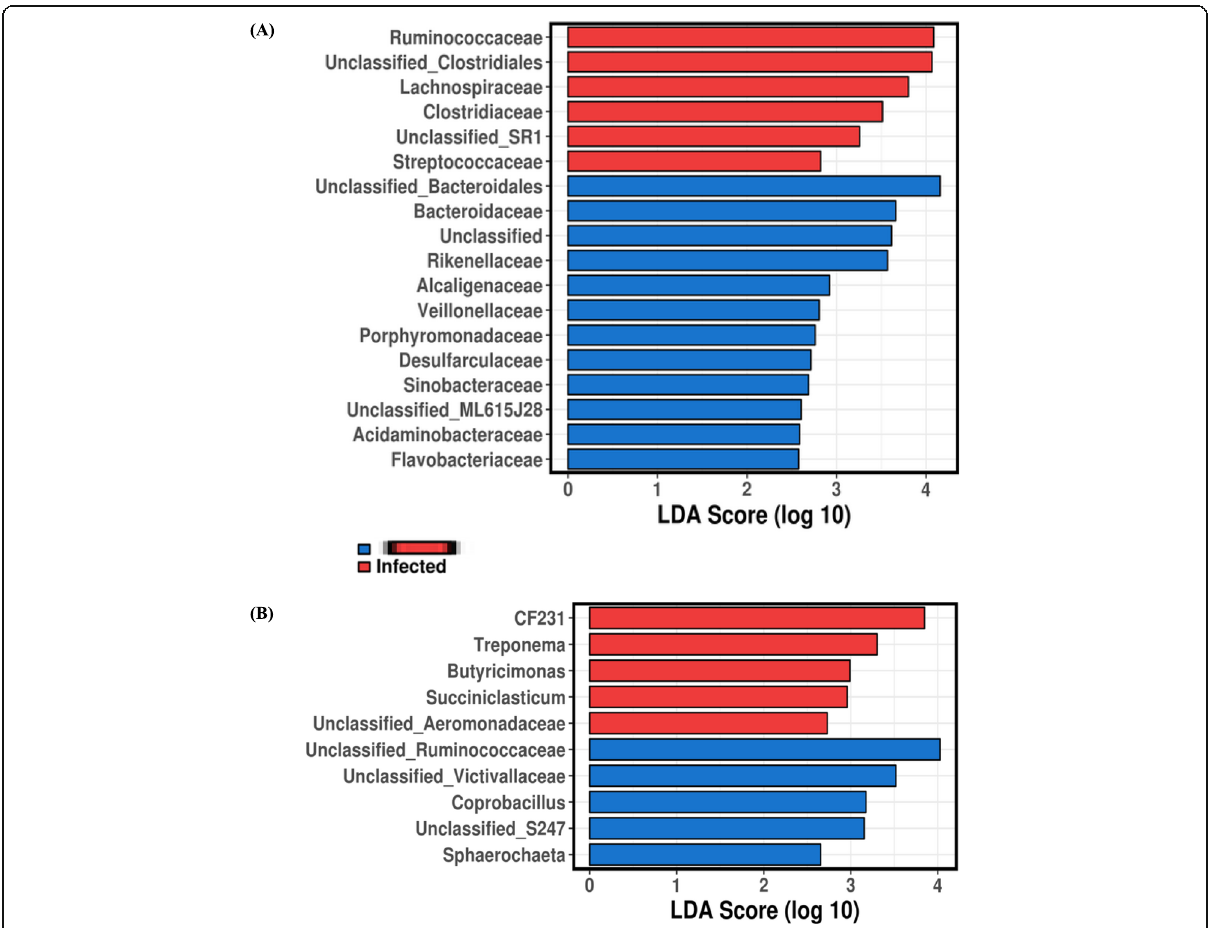
Fig. 7 Significantly discriminative genera with absolute LDA score ≥ 2.0 between uninfected and infected group of sheep using LEfSe. ( a ) high-